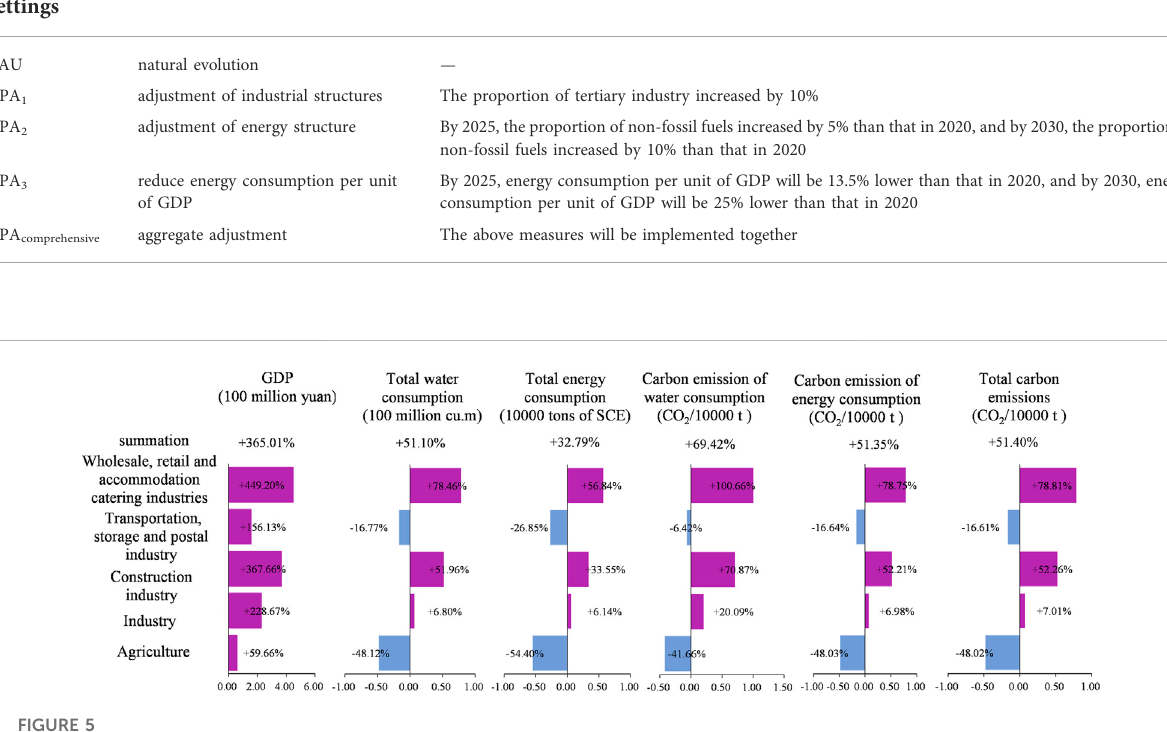
TABLE 2 Direction and measures of situation setting.